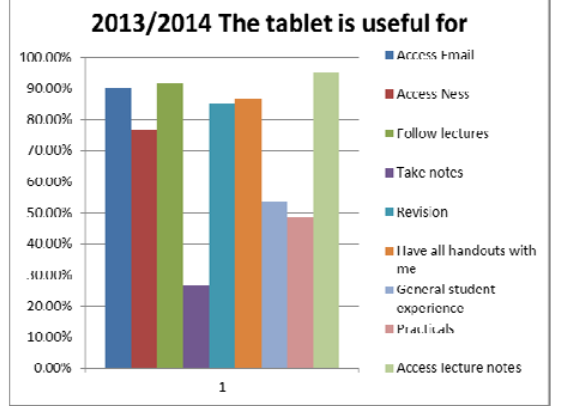
Figure 4. Use of mobile devices by students within the University